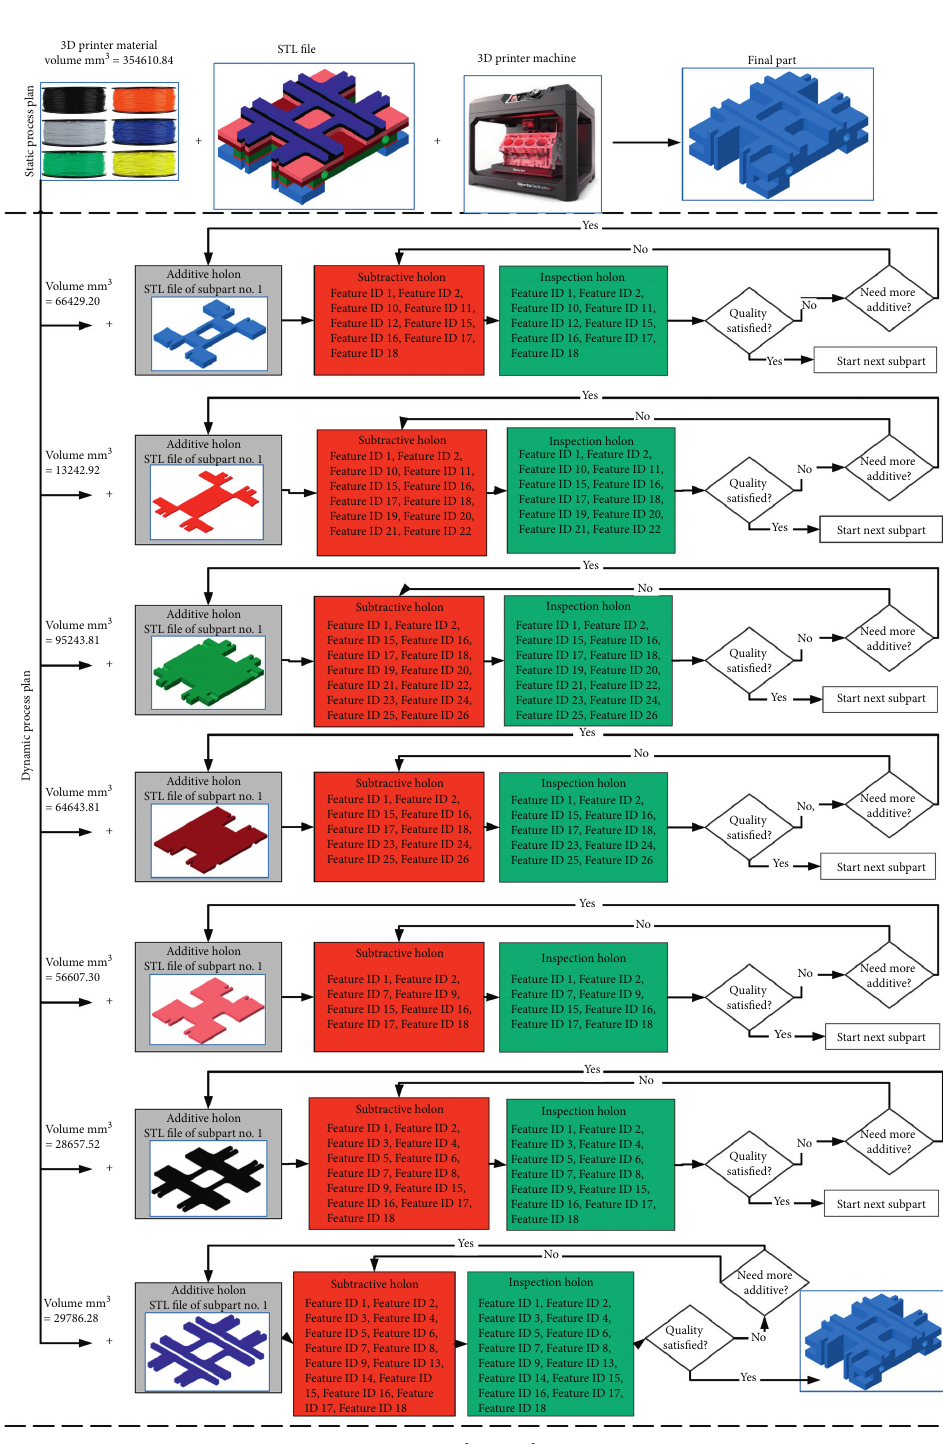
Figure 16: Steps of manufacturing